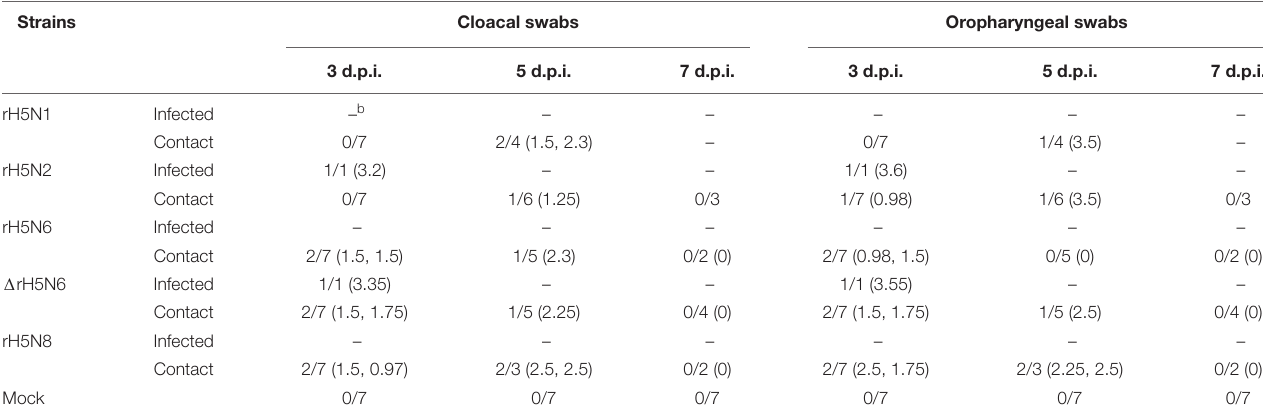
TABLE 2 | Virus titers in chicken cloacal and oropharyngeal swabs a